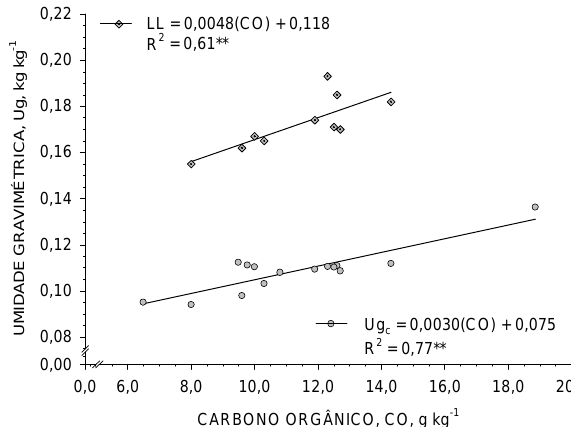
Figura 4. Limite de liquidez (LL) e umidade crítica para compactação (Ug ), considerando o teor c de carbono orgânico de um Argissolo Vermelho-Amarelo arênico (** modelo ajustado é significativo a p ≤≤≤≤≤ 0,01 pelo teste F).